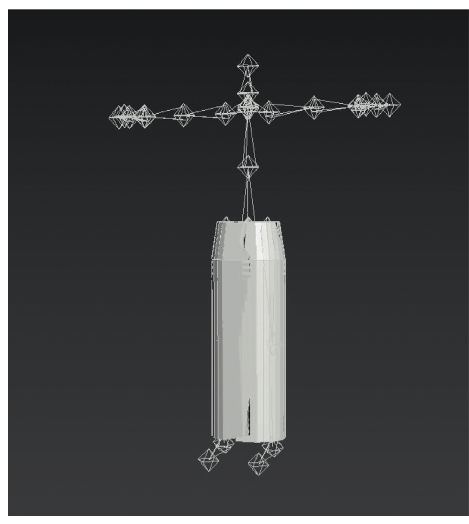
Figure 8: Aligned skeleton and the cloth